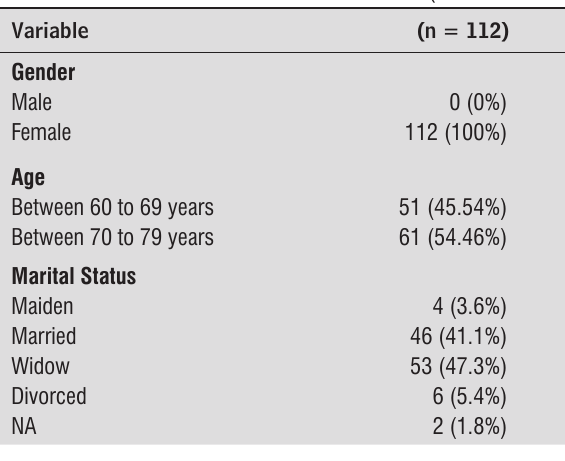
Table 1 - Sociodemographic and clinical characteristics of the